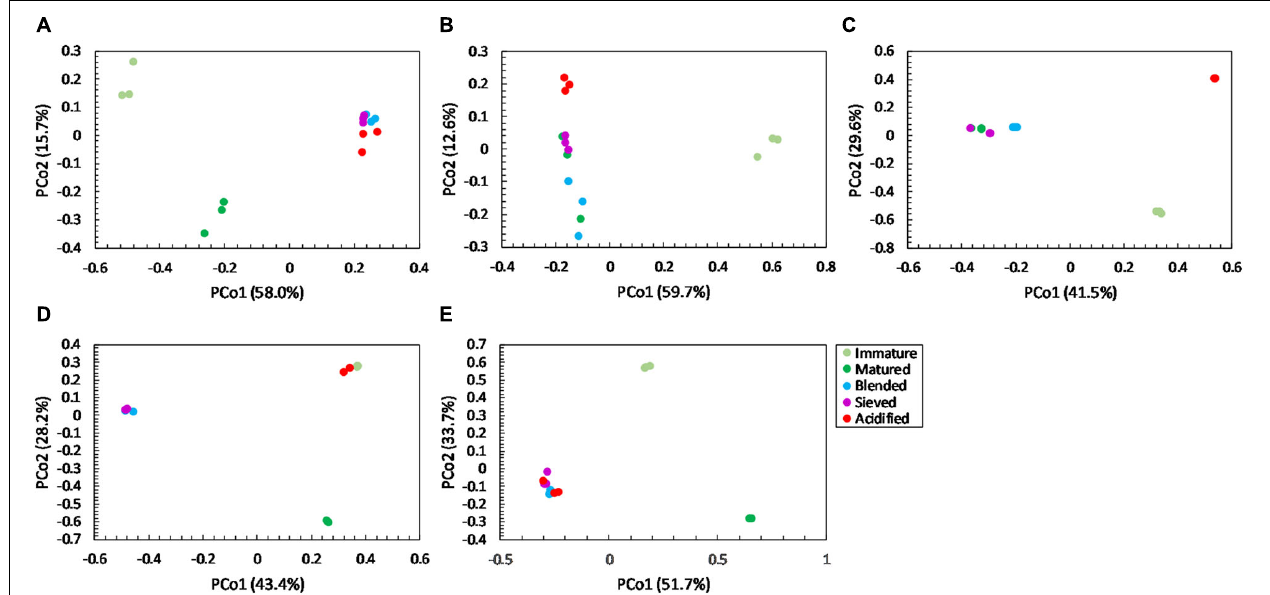
FIGURE 6 | Major shifts in fungal community distribution between immature, matured, blended, sieved and acidified composts in the five compost batches. – Principal Coordinate Analysis (PCoA) profile of pairwise community dissimilarity (Bray-Curtis) indices of fungal (ITS2 gene) sequencing data of the treated composts